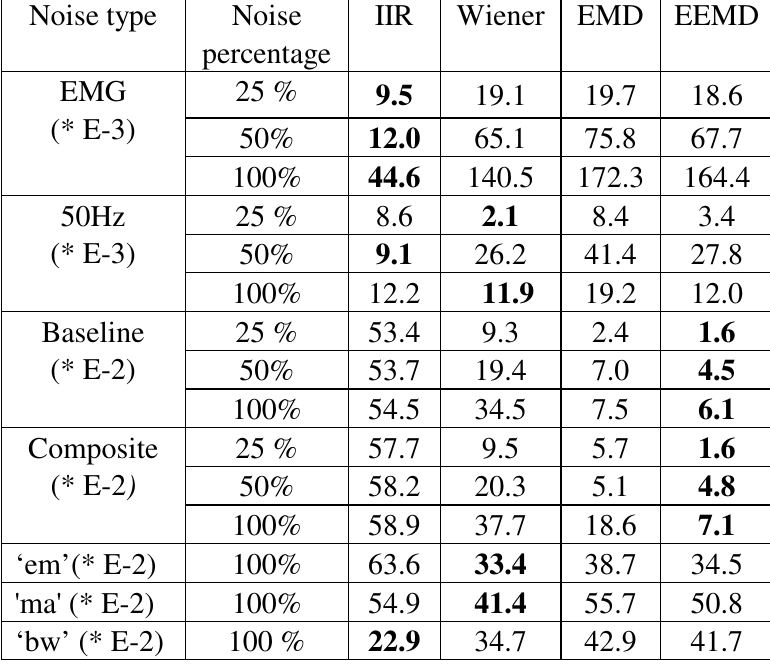
Table 2. MSE result of ventricular arrhythmia ECG of four filter methods with QRS synthetic 100% composite noise and real noises. Minimum MSE of the same noise are mark